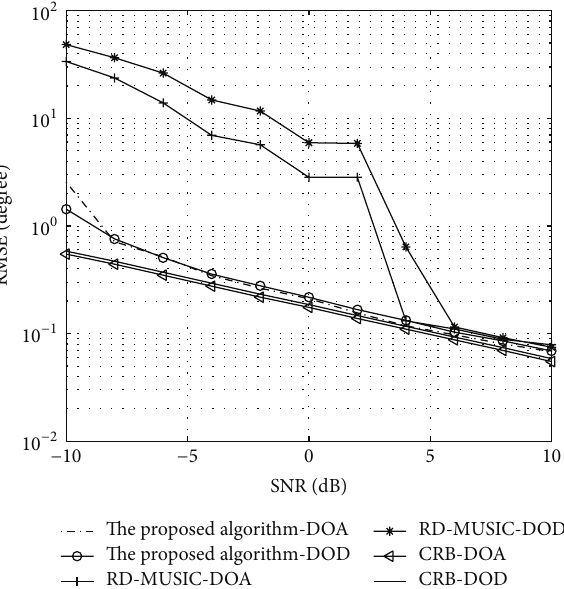
Figure 3: The interference between DOD and DOA